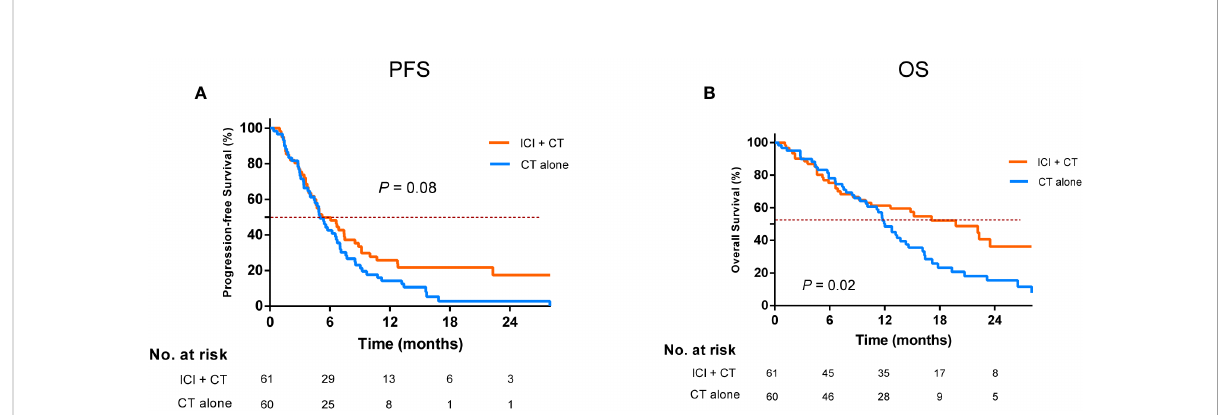
FIGURE 2 Comparison of progression-free survival (A) and overall survival (B) in the ICI combination chemotherapy versus the chemotherapy alone after EGFR-TKI resistance. EGFR, epidermal growth factor receptor; TKI, tyrosine kinase inhibitor; ICI, immune checkpoint inhibitor; CT,